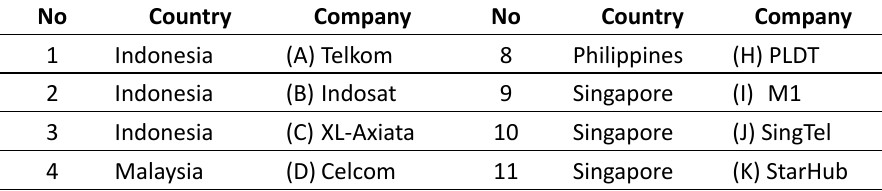
Table 1: DMU of ASEAN-5 Telecommunication